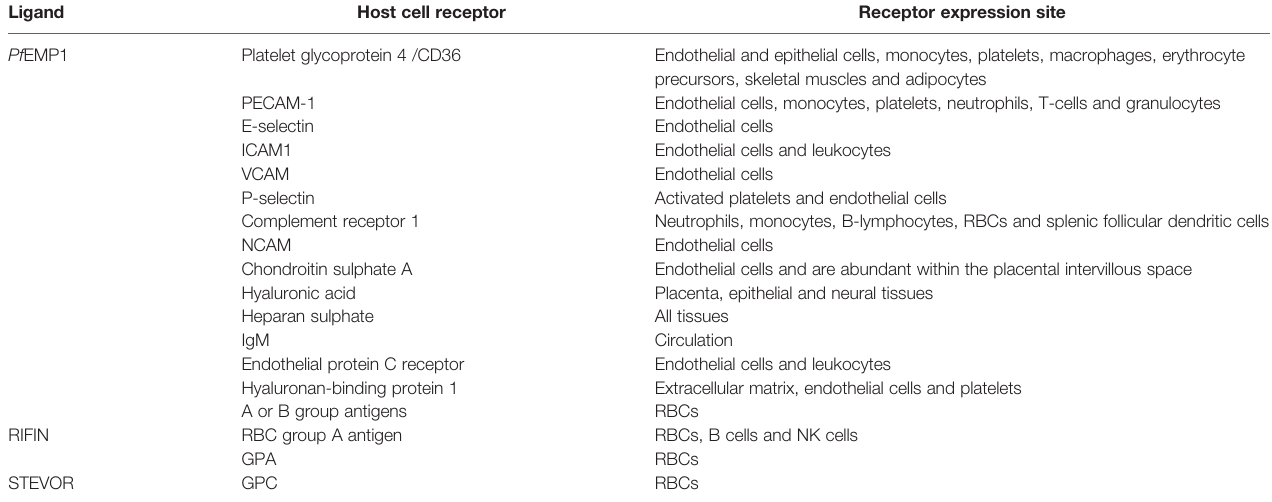
TABLE 3 | Pf EMP1, STEVOR and RIFIN interactions with host cell receptors.